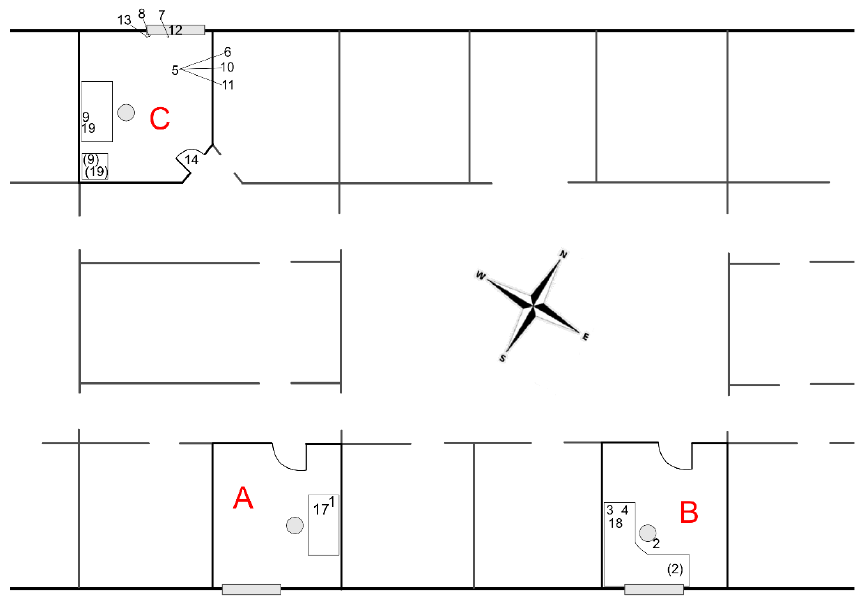
Figure 6. Drawing of the rooms that shows windows, doors, and desks as well as placement of the loggers. Parentheses indicates the first placement before a change in location.